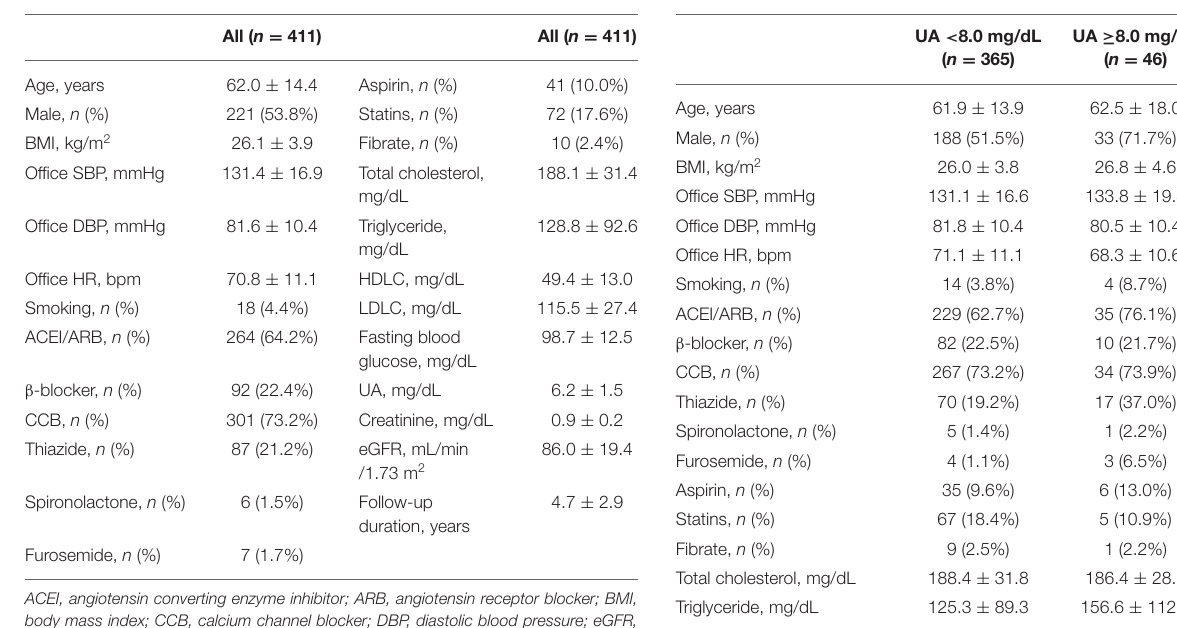
TABLE 1 | Baseline characteristics. TABLE 2 | Baseline characteristics according to uric acid levels ( ≥ 8.0